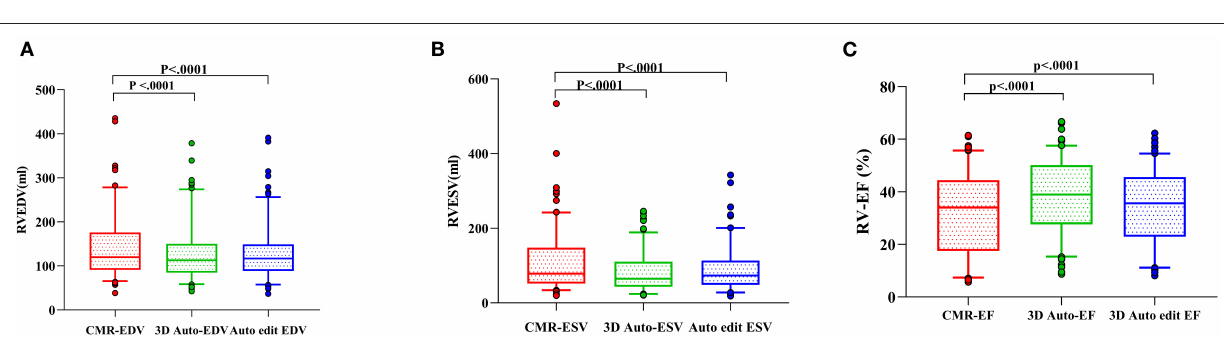
FIGURE 3 | Linear correlation and Bland–Altman analysis of RVEF with 3D auto RV and edit method, with CMR. 3DE auto EF with CMR (A) , 3D auto edit EF with CMR (B) .